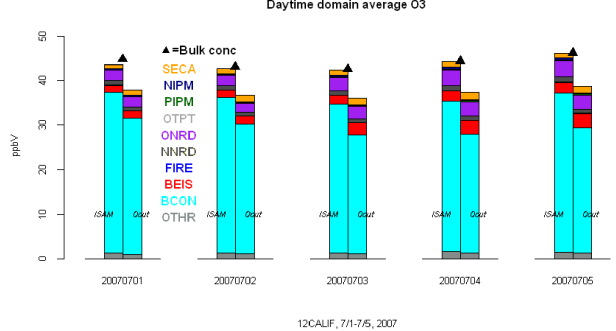
Figure 4. Daytime domain-averaged ambient O 3 , 1–5 July 2007 (28–30 June excluded due to large initial conditions influence). In the bar plot, each day consists of two stacked columns (ISAM on the left; both-out total on the right) and above them a black tri- angle designating bulk ambient concentration calculated from reg- ular CMAQ. The colors represent sector sources: marine (MA- RINE, orange), non-electricity generation units (Non-EGU, deep blue), electricity generation units (EGU, green), other point sources (MEX, light grey), on-road mobile (ONRD, purple), non-road mo- bile (NNRD, yellow), wildfires (FIRE, blue), biogenic (BIOG, red), boundary conditions (BCON, cyan), and remaining unspecified emissions (OTHR, grey).